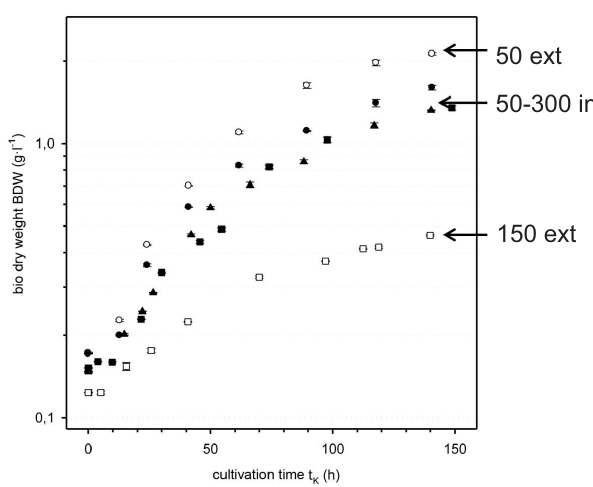
Figure 13. Comparison of internal (int) and external (ext) illumination. The numbers on the right are the diameters of the utilized reactors in